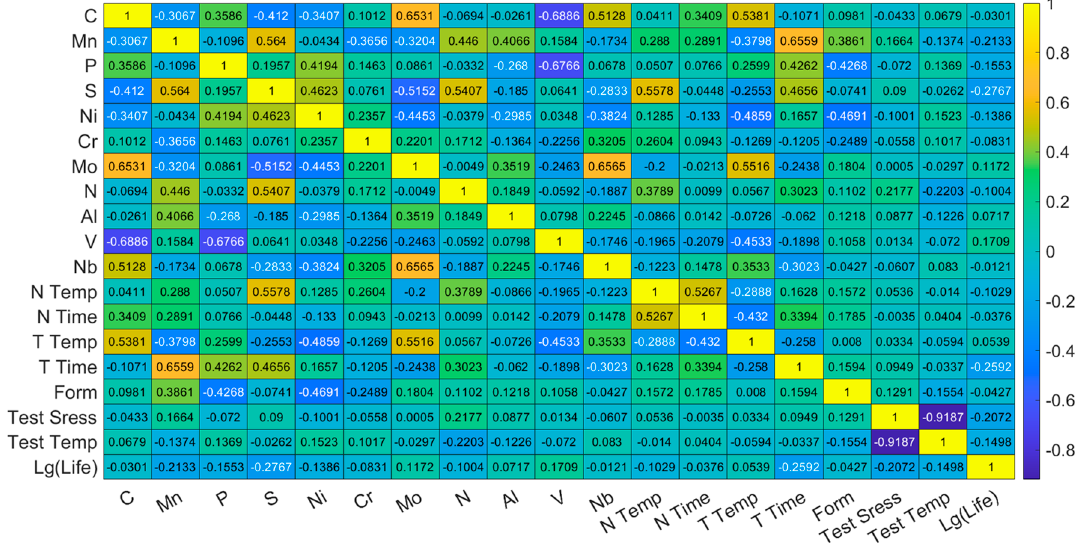
Figure 3. Heat map of the Pearson correlation coefficient.